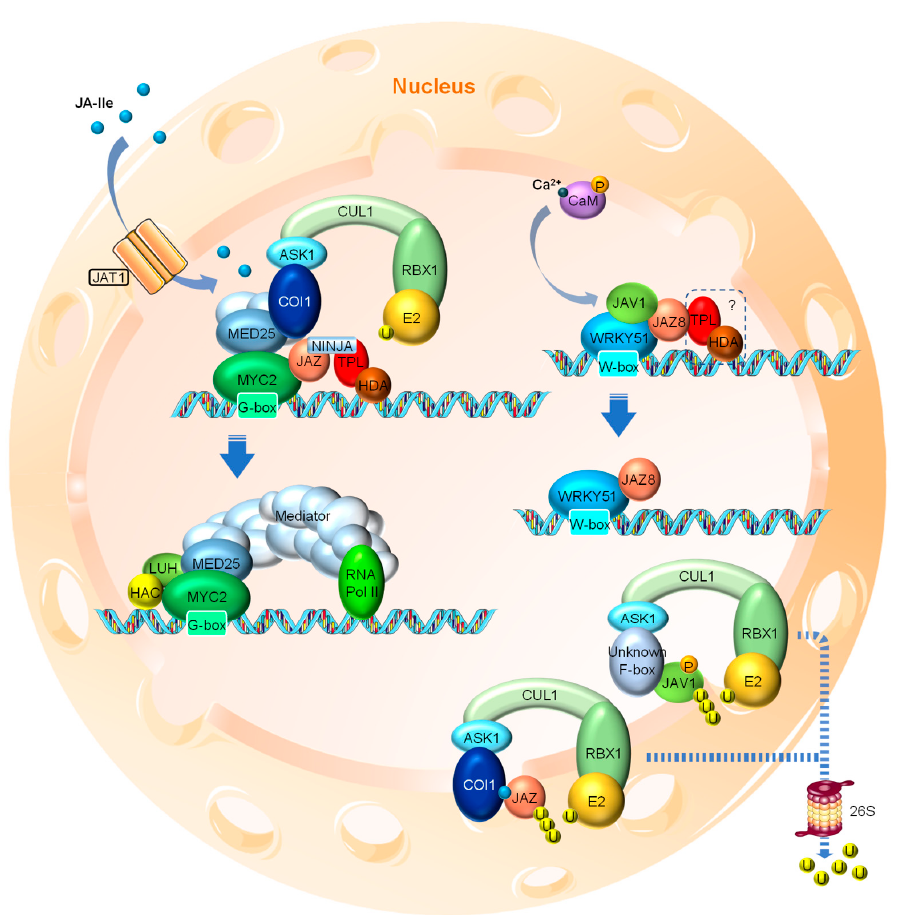
Figure 2. Simplified model of JA signaling in Arabidopsis. When nuclear bioactive JA levels are low, the master transcription factors, such as MYC2, are repressed through the interaction with JAZ proteins that recruit other co-repressors, such as NINJA, TPL and HDA, to form a repressor complex at the promoter regions of JA-responsive genes. In addition, MED25 also physically interacts with MYC2 while bound with COI1, the F-box subunit of the SCF COI1 E3 ubiquitin ligase complex. In the case of the JA biosynthesis gene AOS , its transcription is repressed by the JJW complex composed of JAV1, JAZ8 and WRKY51. In both cases, the expression of JA-responsive genes is restrained. It is unclear whether the JJW complex also recruits co-repressors, such as TPL and HDA. When a certain developmental or environmental cue triggers the import of bioactive JA (e.g., JA-Ile) into the cell nucleus presumably through the action of JAT1, elevated levels of JA-Ile cause the formation of COI1-JA-JAZ co-receptor complex. The interaction between COI1 and JAZ leads to the dissociation of JAZ and MYC2, as well as the dissociation of COI1 and MED25. As a result, JAZ is degraded via the 26S proteasome and the enhanced interaction between MED25 and MYC2 ultimately leads to MED25-mediated transcriptional activation of the target genes. In the case of JJW-regulated AOS , stress-induced fast Ca 2+ influx leads to the CaM-mediated phosphorylation of JAV1. JAV1 phosphorylation causes the disintegration of the JJW complex and AOS transcriptional activation. Phosphorylated JAV1 is subjected to E3 ubiquitin ligase- mediated ubiquitination and 26S proteasomal degradation, although the F-box protein responsible for the specific recognition of JAV1 remains to be identified. JAZ, JASMONATE ZIM DOMAIN; NINJA, NOVEL INTERACTOR OF JAZ; TPL, TOPLESS; HDA, HISTONE DEACETYLASE; MED25, MEDIATOR25; COI1, CORONATINE INSENSITIVE1; ASK1, ARABIDOPSIS SKP1-RELATED1; CUL1, CULLIN1; SCF, SKP1-CULLIN1-F-box; HAC1, HISTONE ACETYLTRANSFERASE1; LUH, LEUNIG_HOMOLOG; JAV1, JASMONATE ASSOCIATED VQ DOMAIN PROTEIN1; AOS, ALLENE OXIDE SYNTHASE; CaM, Calmodulin. RBX1 is a RING finger protein that recruits the E2 ubiquitin-conjugating enzyme to the C-terminus of